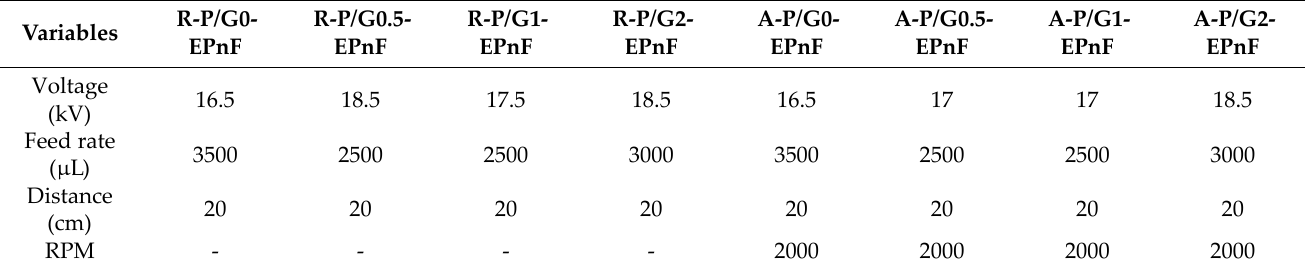
Table 1. ES parameters for the preparation of A-P/G-EPnF and R- P/G-EPnF meshes.